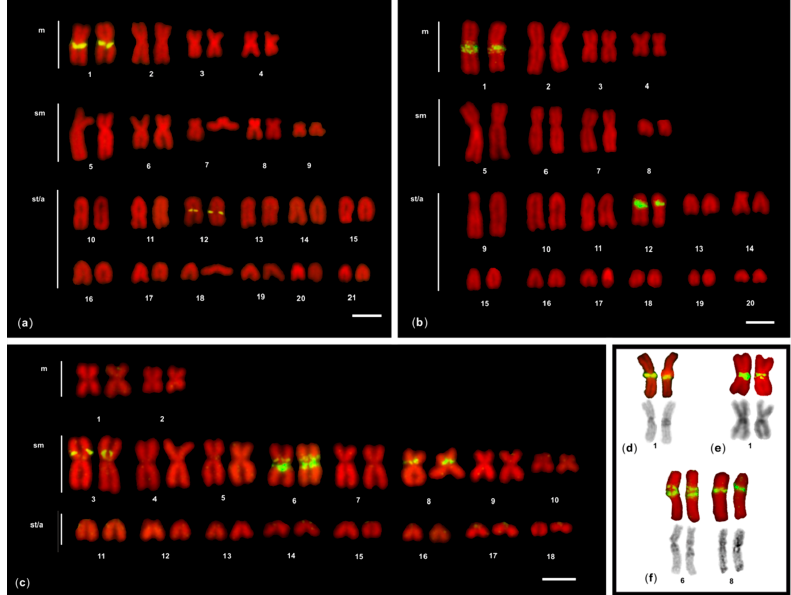
Figure 1. Karyotypes of ( a ) Muraena helena ; ( b ) Gymnothorax javanicus; and ( c ) G. flavimarginatus after 5S rDNA (yellow fluorescence)FISH. The chromosomes were counterstained with propidium iodide. m : metacentric chromosomes, sm : submetacentric chromosomes, st / a : subtelocentric / acrocentric chromosomes. In the inset, the bi ‐ armed 5S ‐ bearing pairs of ( d ) M. helena ; ( e ) G. javanicus; and ( f ) G. flavimarginatus after sequential FISH (above) and C ‐ banding (below) showing the overlapping of 5S markings and hererochromatic C ‐ band. The bar represents 5 μ m.